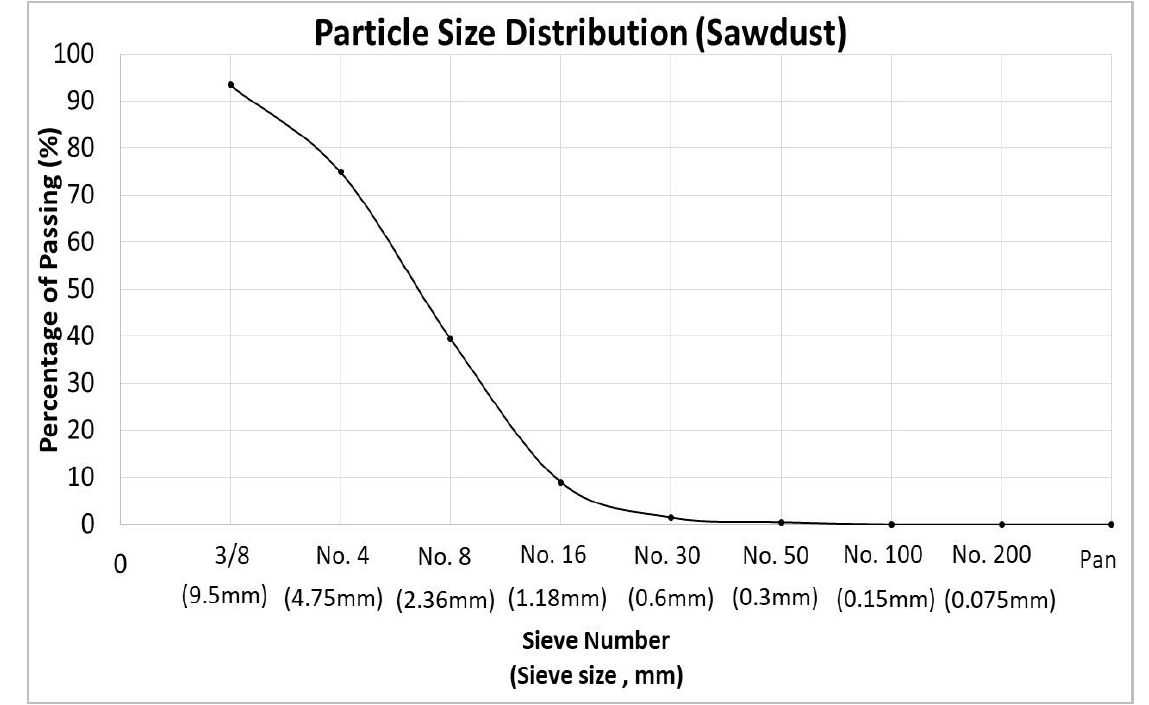
Figure 4. Particle Size Distribution for Sawdust Particle.